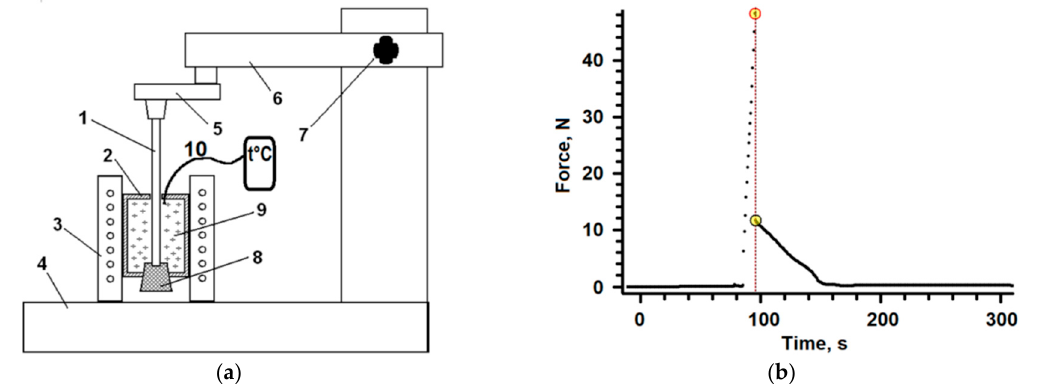
Figure 6. ( a ) Scheme of an experimental setup for measuring the shear adhesion strength of ice [103]. 1 — test sample; 2 — vessel with water/ice; 3 — freezing device; 4 — base; 5 — force sensor; 6 — movable lever;7 — lever drive knob; 8 — plug; 9 — ice; 10 — thermocouple; ( b ) Typical time dependence of force measured by the force sensor. Circles mark the maximum load force and the residual force after the failure of adhesion contact. Note that the non ‐ zero residual force here results from the friction of an ice and the sample upon its movement in the iced bath after adhesion contact breaking.